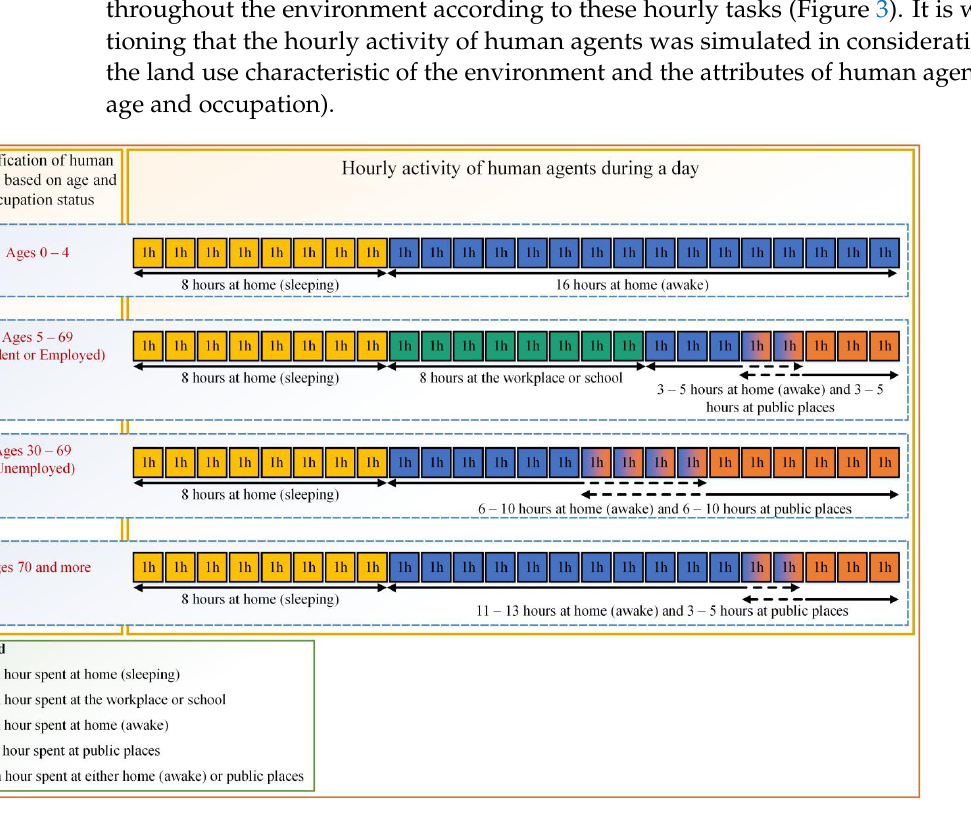
Figure 3. The hourly activity of human agents during a day based on their age and occupation.